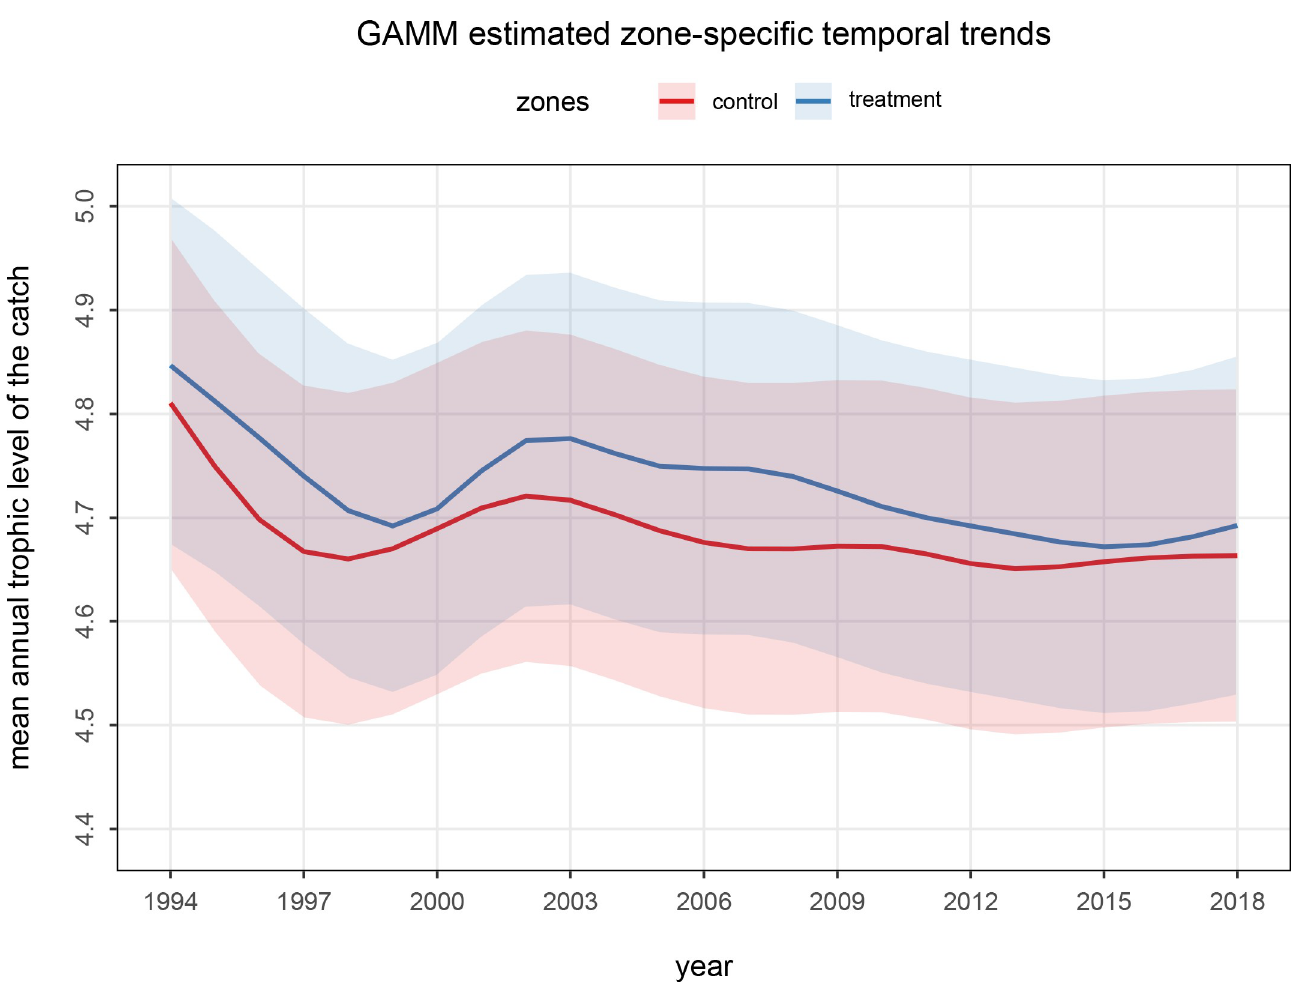
Fig 2. Comparison of the estimated annual trends in the mean trophic level of the catch (TLc) inside ( treatment ) and outside ( control ) combined treatment zones (Kingman/Palmyra 110 nm + Johnston 260 nm) derived using a GAMM regression model with Gaussian likelihood fitted to the set-specific catch data. Solid curves show the zone-specific mean trends and the shaded polygons show the zone-specific 95% confidence intervals.